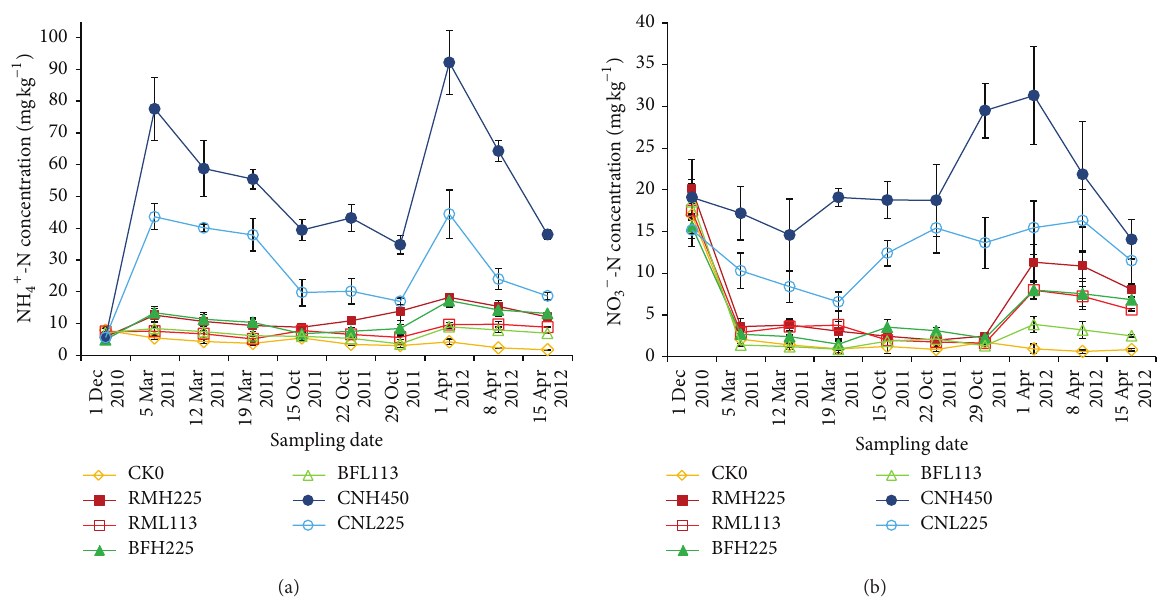
Figure 3: Variations in soil concentrations of (a) NH 4+ -N and (b) NO 3− -N in tea fields during 2010-2012 (CK0: unfertilized; RMH225: raw materials applied at 225 kgN ha −1 yr −1 ; RMH113: raw materials applied at 113 kgN ha −1 yr −1 ; BFH225: biofertilizer applied at 225 kg N ha −1 yr −1 ; BFH113: biofertilizer applied at 113kg N ha −1 yr −1 ; CNH450: urea applied at 450 kg Nha −1 yr −1 ; and CNH225: urea applied at 225 kgN ha −1 yr −1 ).